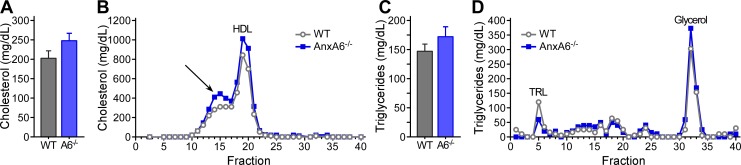
Serum triglyceride and cholesterol profiling in HFD-fed WT and AnxA6-KO mice.(A, C) Total cholesterol and triglyceride levels showed no significant differences between genotypes. (B, D) Pooled serum samples from 3 mice of each genotype were separated by fast-performance liquid chromatography (FPLC) and each fraction was analyzed for cholesterol and triglyceride content. (B) Cholesterol profiling with HDL (fractions #18–20) and neighboring cholesterol-rich fractions (see arrow; #13–17), likely representing HDL- or LDL subspecies. (D) Triglyceride-rich lipoproteins (TRL, fraction #5) and free glycerol (fractions #31–34).